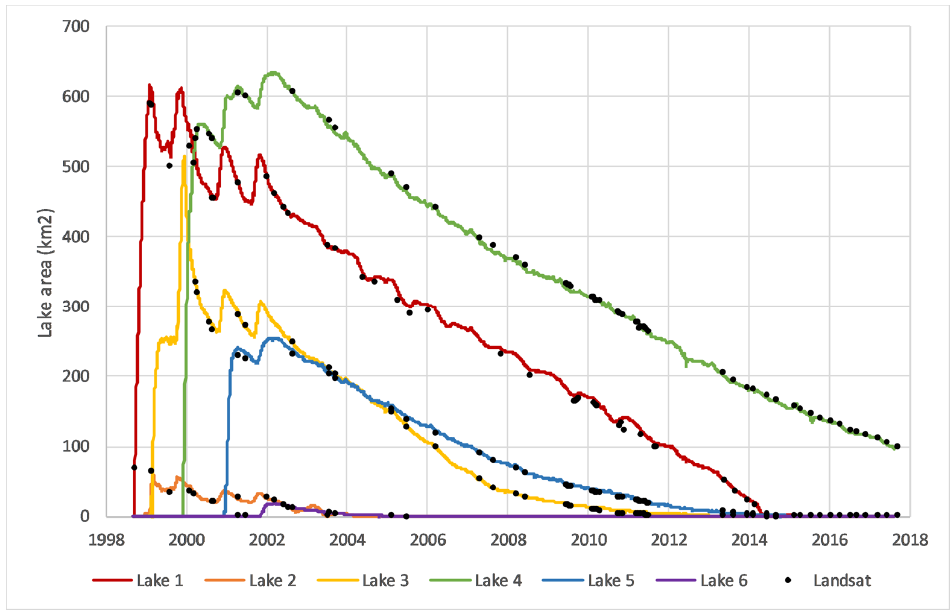
Figure 8. Lake surface area (km 2 ) for each lake, 1998–2017. Colored lines are merged AVHRR/MODIS; black dots are individual lake measurements from Landsat, for validation. Table 4. Maximum surface area and date of maximum for each lake.